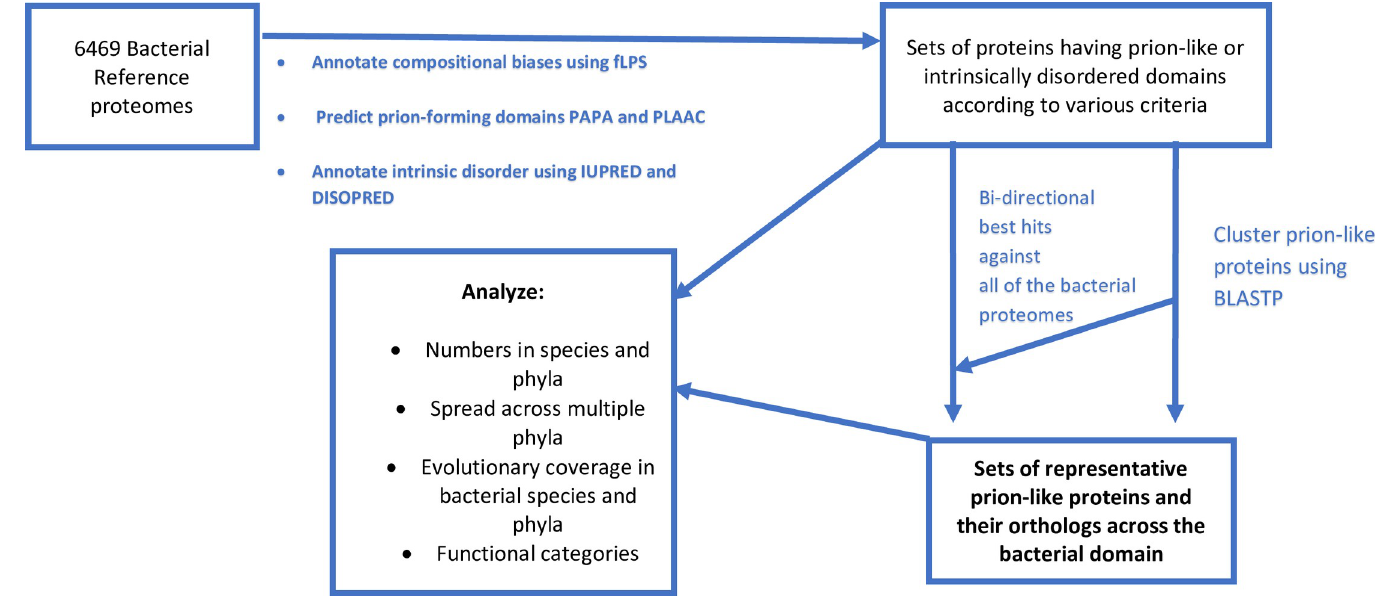
Fig 2. A schematic of the analysis performed on bacterial proteomes for the evolutionary penetrance of prion-like proteins.